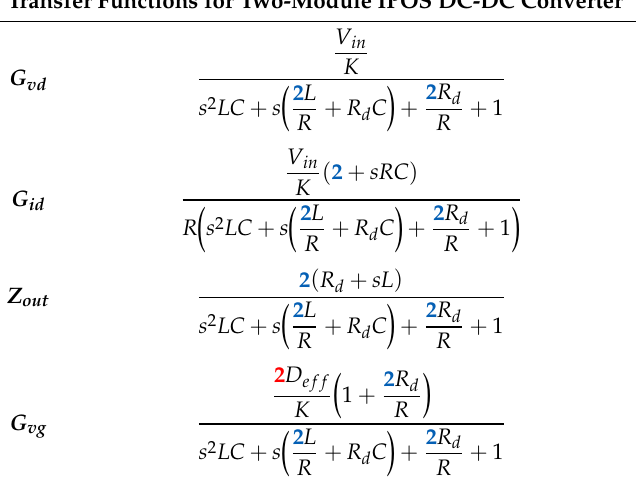
Table 3. Generalized model verification with the two-module IPOS power converter.